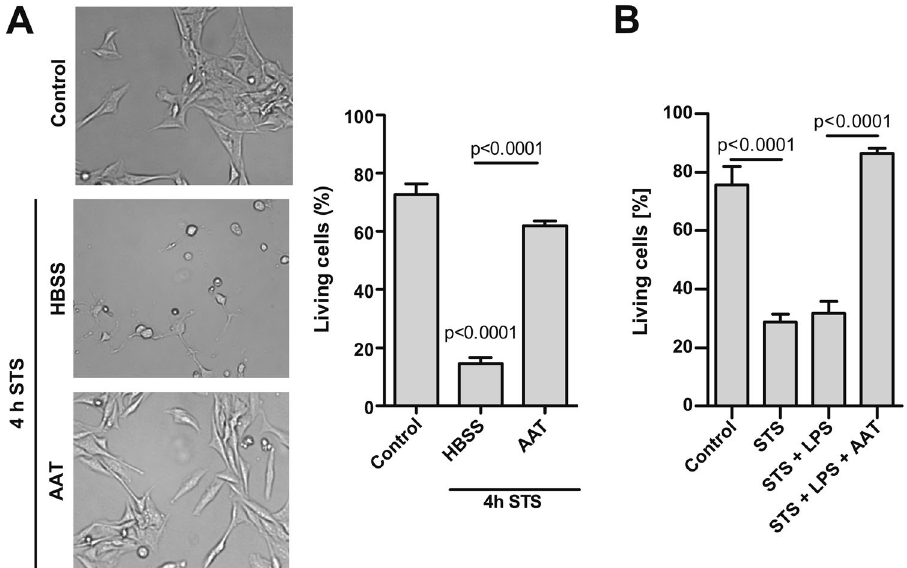
Figure 4. Inhibition of STS-induced apoptosis by AAT does not require a direct STS-AAT interaction and is not affected by LPS. ( A ) Cells were incubated with 50 nM STS for 4 h, thereafter STS was removed and the cells were incubated with HBSS (control) or 1.5 mg/ml AAT in fresh medium for additional 18 h. Cell images were taken under the phase contract microscopy. Apoptosis was analyzed by flow cytometry using PE Annexin V Apoptosis assay to detect living cells. Each bar represents mean (SD) percentage (%) of living cells of three independent experiments. p < 0.05 was considered as significant. ( B ) Cells were treated with STS (50 nM), or LPS (10 µ g/ml), or AAT (1.5 mg/ml) separately or in combinations for 18 h. Apoptosis was analyzed by flow cytometry using PE Annexin V Apoptosis assay to detect living cells. Each bar represents mean (SD) percentage (%) of living cells of three independent experiments. p < 0.05 was considered as significant.